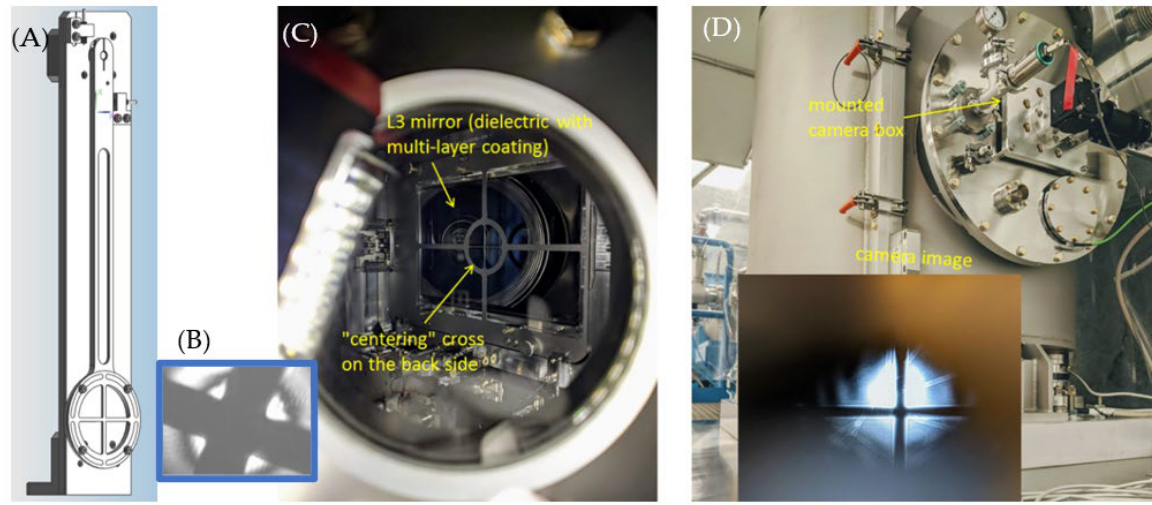
Figure 5. Three-dimensional model of alignment crosses ( A ), picture of the beam at the position of an alignment cross ( B ), L3BT mirror mount with reference cross ( C ), and corresponding camera box and image of the cross in the small insert ( D ).